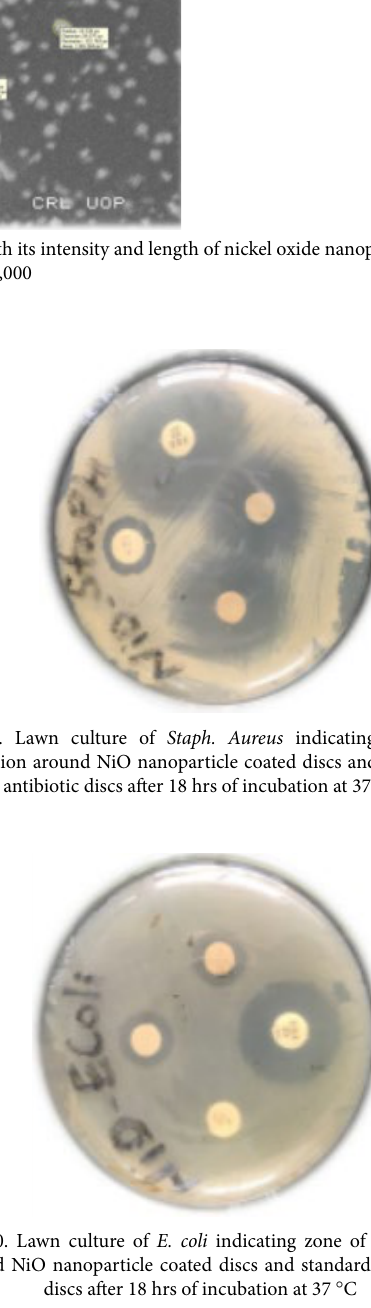
Fig 11. Graphical presentation of nanoparticle coated antimicrobial discs and standard antibiotic discs against Staph. aureus and E. coli